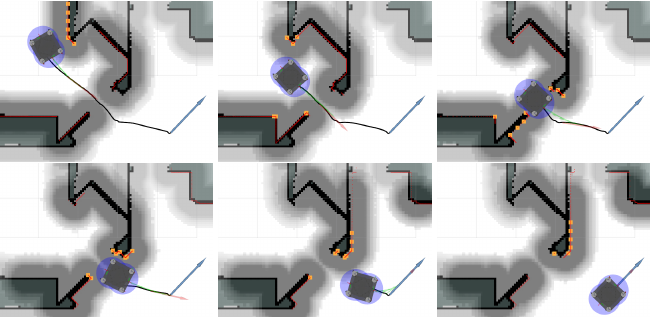
Figure 16. Set of snapshots illustrating the interaction between the global planner (the planned path is depicted as a black line and the goal is light-blue). The red arrow depicts the current local goal that the proposed local planner is driving towards, the green arrows depict the future horizon states (also see the caption in Figure 15. Due to the look ahead, the optimization allows for a smoother driven path compared to the relatively non-smooth and jerky path provided by the global path